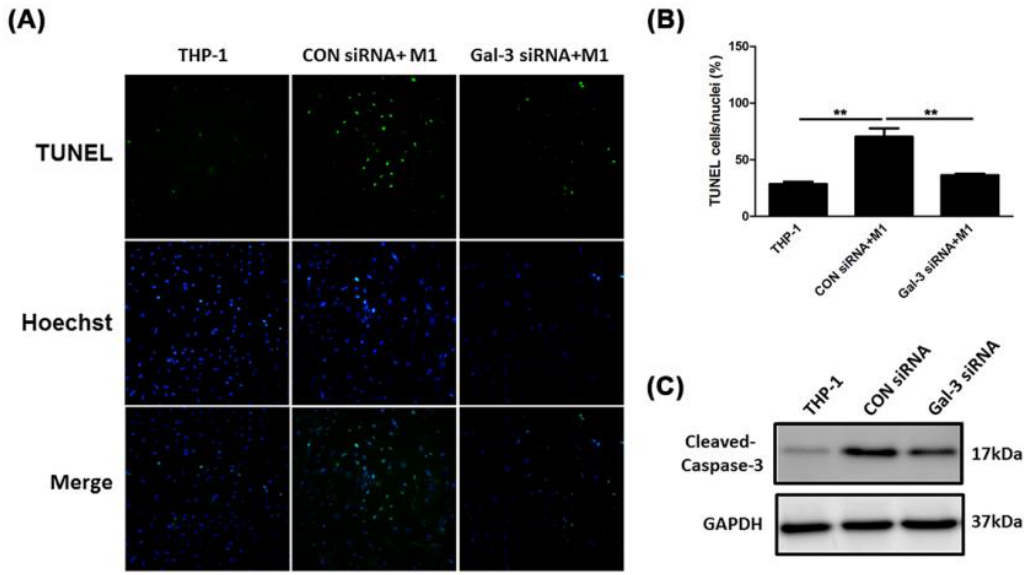
Figure 4. Inhibition of Gal-3 attenuated macrophage-induced death of SMCs. A7R5 cells were incubated with di ff erent treatment CM, respectively. ( A ) Representative photographs of TUNEL staining. Apoptotic cells are shown in green and cell nuclei are shown in blue. The magnification was 200 × . ( B ) Quantitative analysis of apoptotic cell death was represented as the percentage of TUNEL positive nuclei. ** p < 0.001. ( C ) Representative Western blots demonstrating expression in the active, cleaved form of caspase-3 protein; GAPDH was used as a loading control.